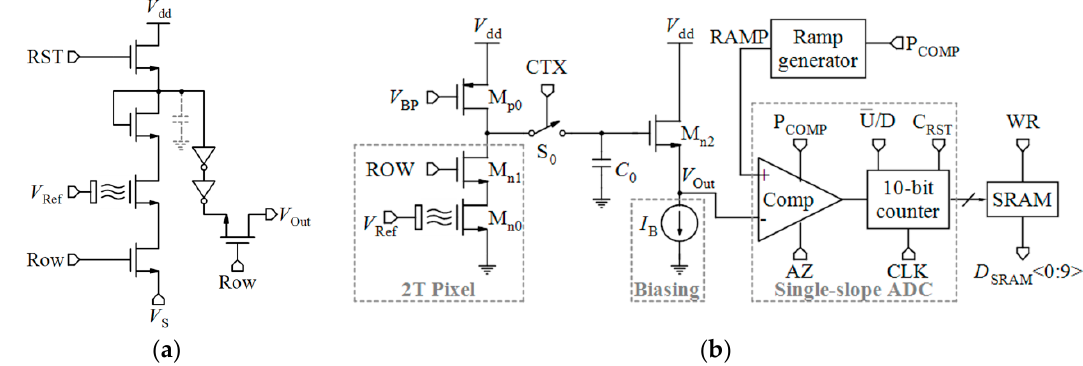
Figure 29. ( a ) An active pixel sensors (APS) based pH-to-time converter; ( b ) a readout circuit comprising a pH-to-time-to- voltage conversion (pH-TVC) amplification circuit and 10-bit voltage digital converter.